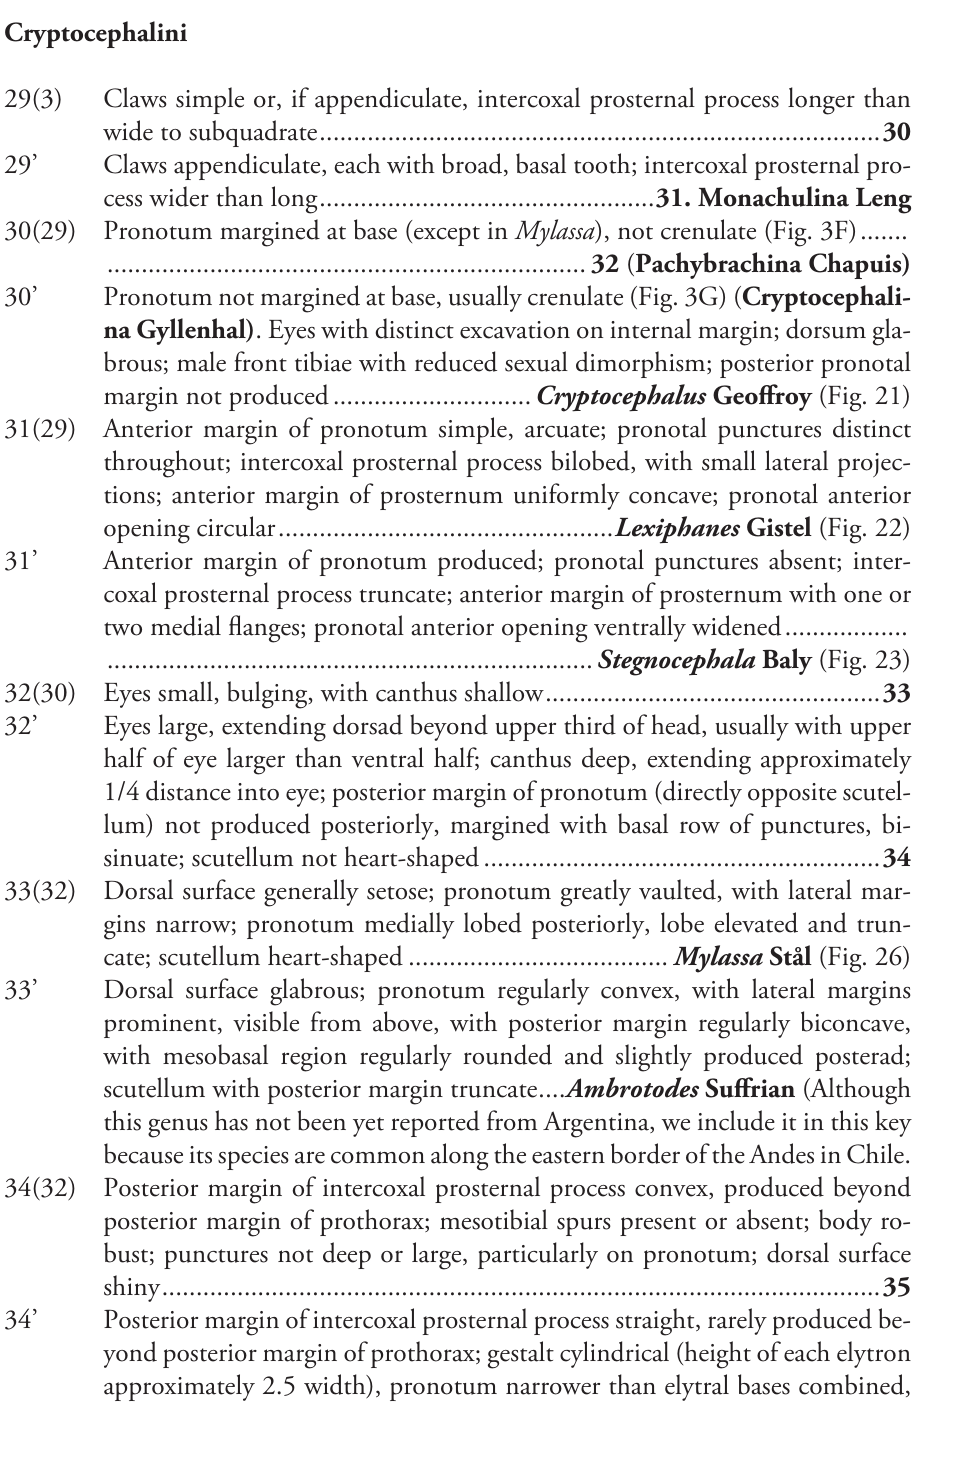
32’ Eyes large, extending dorsad beyond upper third of head, usually with upper half of eye larger than ventral half; canthus deep, extending approximately 1/4 distance into eye; posterior margin of pronotum (directly opposite scutel- lum) not produced posteriorly, margined with basal row of punctures, bi- Dorsal surface generally setose; pronotum greatly vaulted, with lateral mar- gins narrow; pronotum medially lobed posteriorly, lobe elevated and trun- 33’ Dorsal surface glabrous; pronotum regularly convex, with lateral margins prominent, visible from above, with posterior margin regularly biconcave, with mesobasal region regularly rounded and slightly produced posterad; scutellum with posterior margin truncate .... Ambrotodes Suffrian (Although this genus has not been yet reported from Argentina, we include it in this key because its species are common along the eastern border of the Andes in Chile. 34(32) Posterior margin of intercoxal prosternal process convex, produced beyond posterior margin of prothorax; mesotibial spurs present or absent; body ro- bust; punctures not deep or large, particularly on pronotum; dorsal surface 34’ Posterior margin of intercoxal prosternal process straight, rarely produced be- yond posterior margin of prothorax; gestalt cylindrical (height of each elytron approximately 2.5 width), pronotum narrower than elytral bases